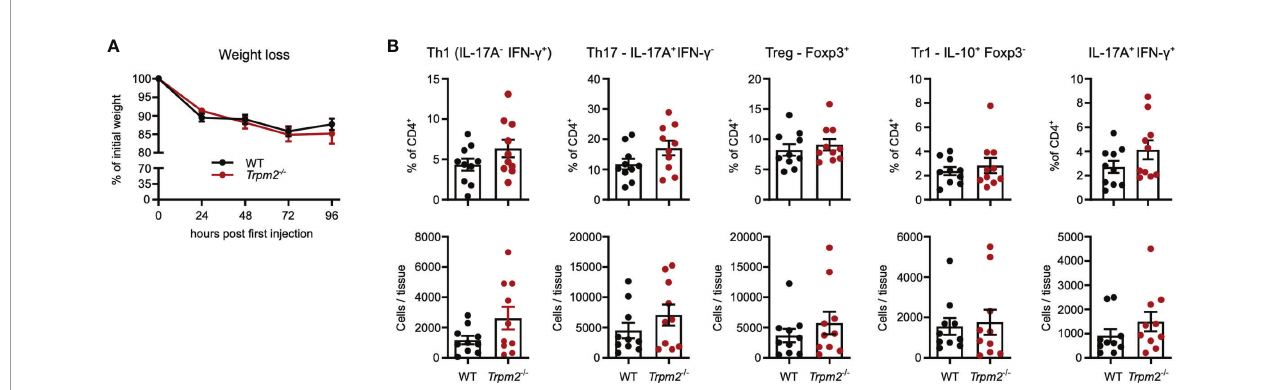
FIGURE 6 | TRPM2 de fi ciency does not impair the CD4 + T-cell response in response to anti-CD3 mAb induced intestinal in fl ammation. Mice were i.p. injected with anti-CD3 mAb on days 0, 2, and 4 and analyzed 4 h after the last injection. (A) Percentage of initial body weight. (B) Frequencies and numbers of different CD4 + T-cell populations in the small intestinal mucosa. Bars depict mean ± SEM. Results were analyzed with the Mann – Whitney test. Data were pooled from two independent